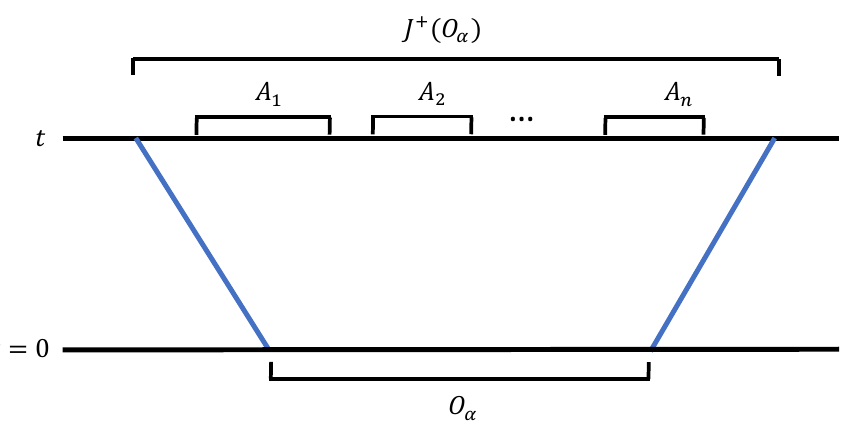
Figure 9 . Regions J + ( O α ) and A 1 , A 2 , . . . , A n . In the random void distribution, the probability of forming a void in A ≡ A 1 A 2 . . . A n depends only on the lengths | A 1 | , . . . , | A n |